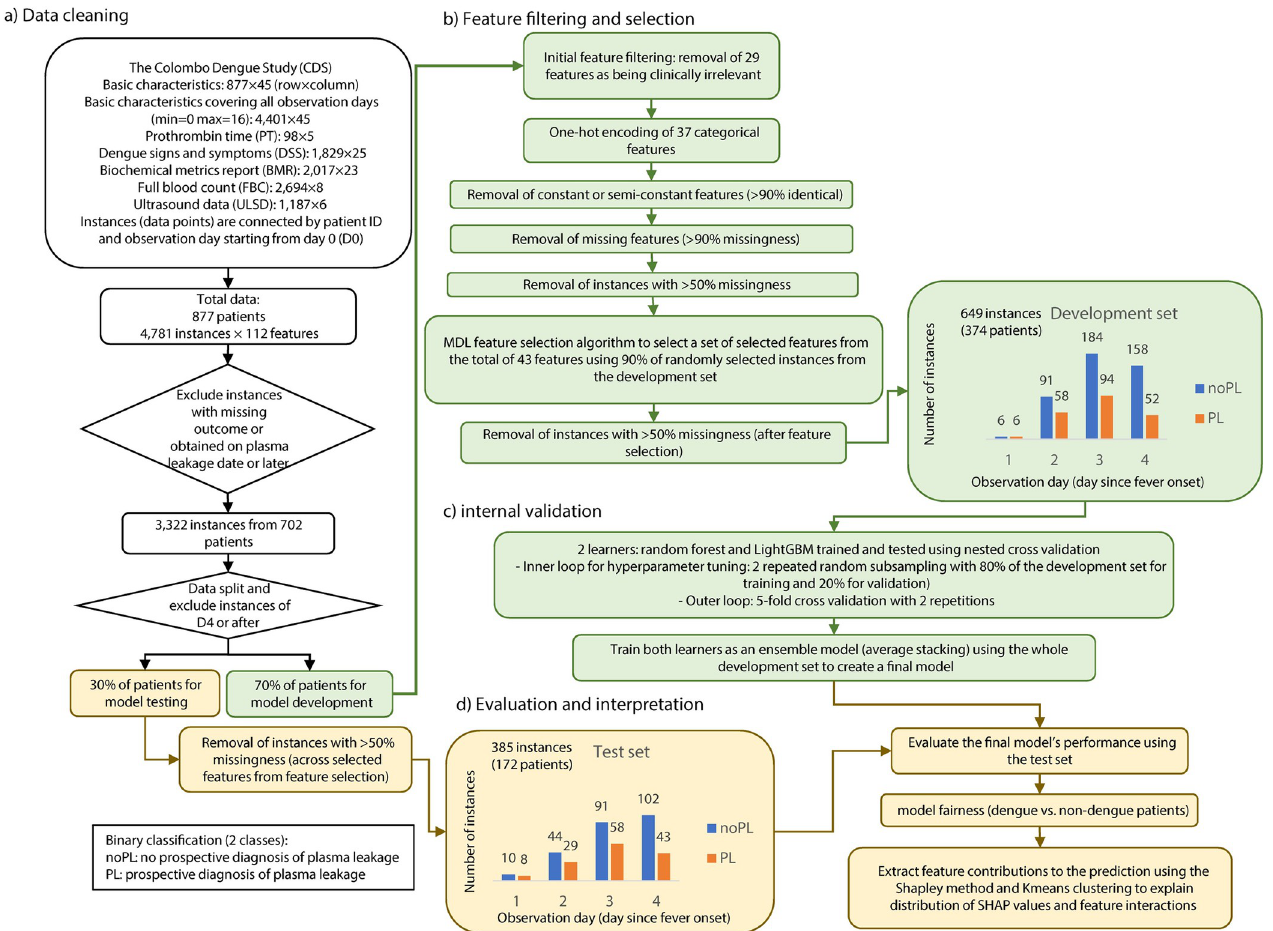
Fig 1. A summary of the study workflow. a) Data cleaning, where the datasets in tabular form were merged and instances not meeting the mentioned criteria were removed and the remining instances were split into a development and a test set. b) Feature filtering and selection, where the five most relevant features associated with the outcome variable were selected for the learning process. c) Internal validation, where two learners compete to predict the occurrence of plasma leakage based on the selected sets of features. The learners were then trained using the whole development set to create an ensemble model based on average stacking as a final model. d) Evaluation and interpretation, where the final model is evaluated using the test set and the contribution of the selected features were elucidated using the Shapley method.